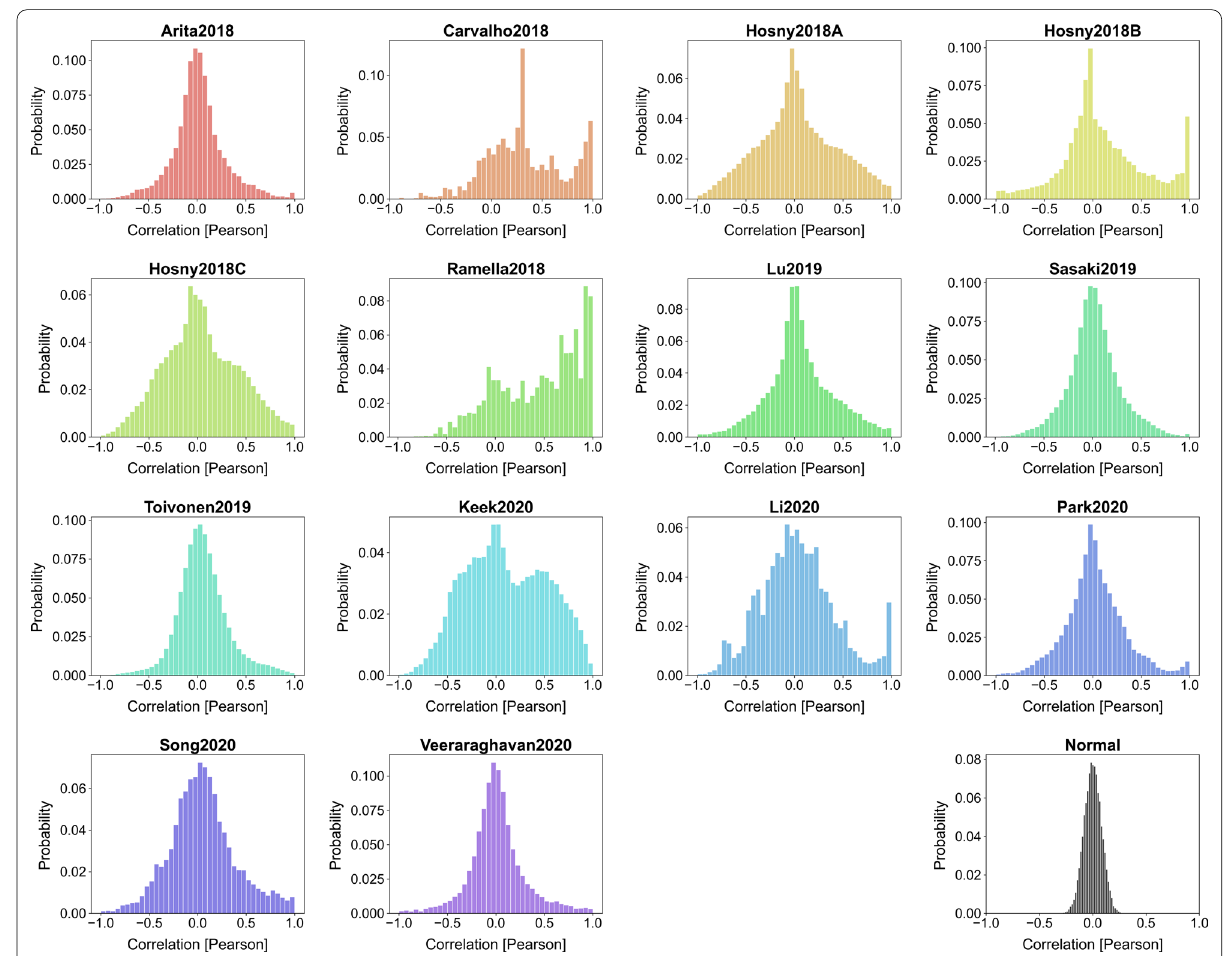
Fig. 2 Histogram of the Pearson correlation between all features. The “Normal” histogram was obtained by creating a dummy dataset that only contained independent and normally distributed features and serves as a